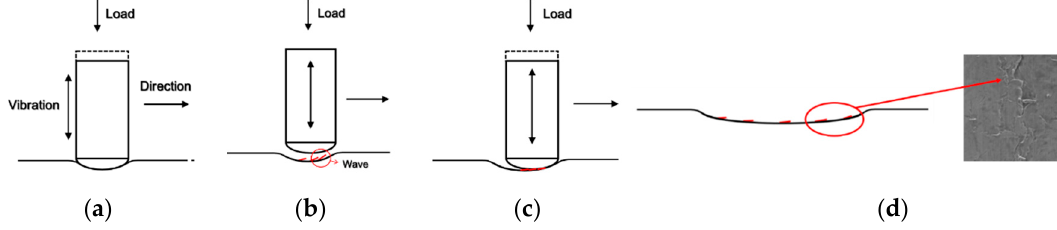
Figure 17. Mechanical overlapping model by UNSM treatment: ( a ) beginning stage; ( b ) wave formation; ( c ) ultrasonic tip movement; ( d ) overlapped area formation and the evidentiary image.